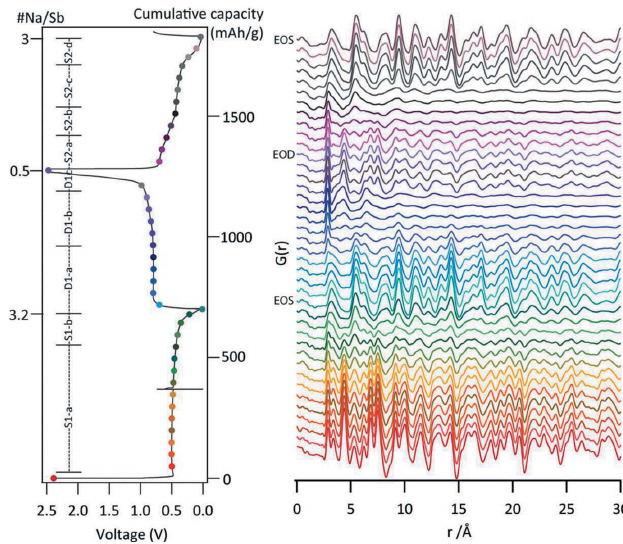
Figure 8 Discharge (cid:5) charge curves for Sb-containing cells and the corresponding operando PDF measurements. Reprinted with permission from Allan et al. (2016). Published by the American Chemical